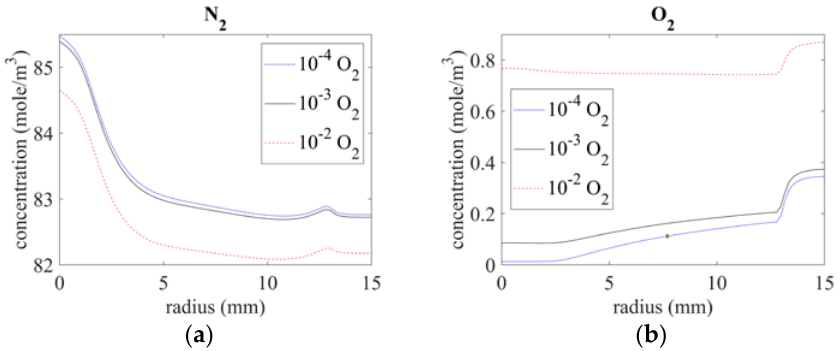
Figure 6. Species distribution of ( a ) N 2 and ( b ) O 2 on the surface.